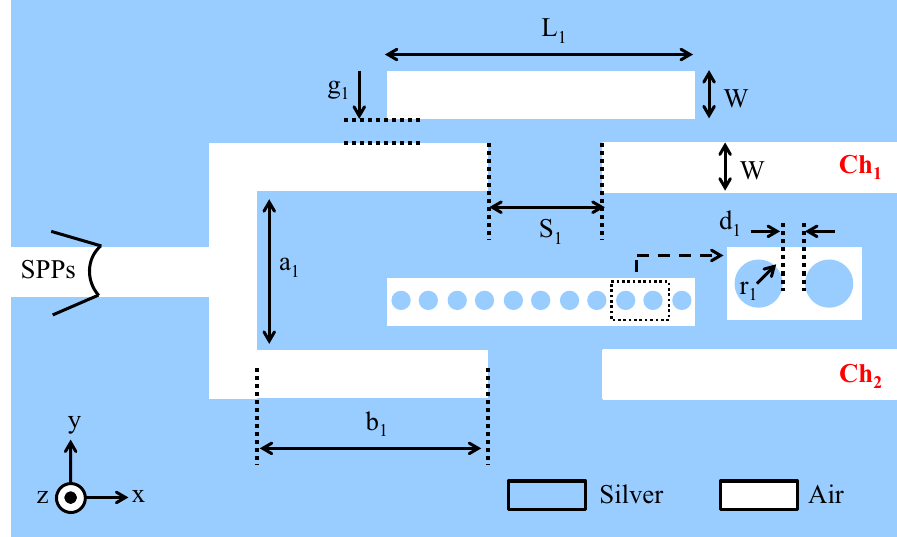
Figure 6. Schematic of the proposed two-channel DEMUX.